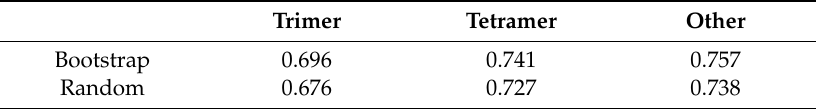
Table 3. Bootstrap method compared with random